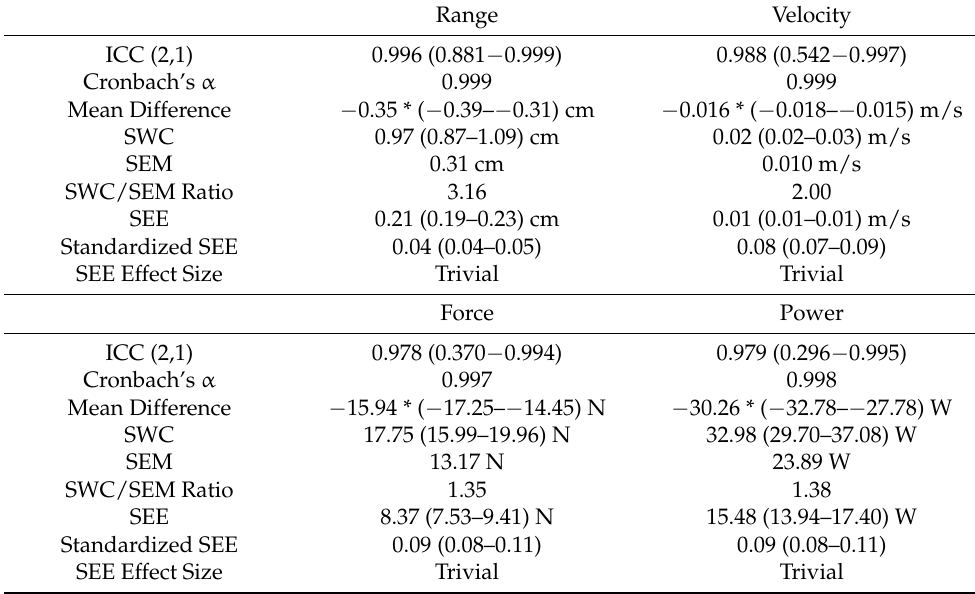
Table 1. Reliability of video and LPT